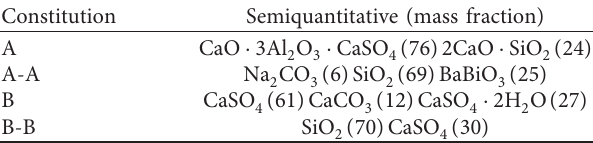
Table 1: Constitution and mass fraction of HWM. Constitution Semiquantitative (mass